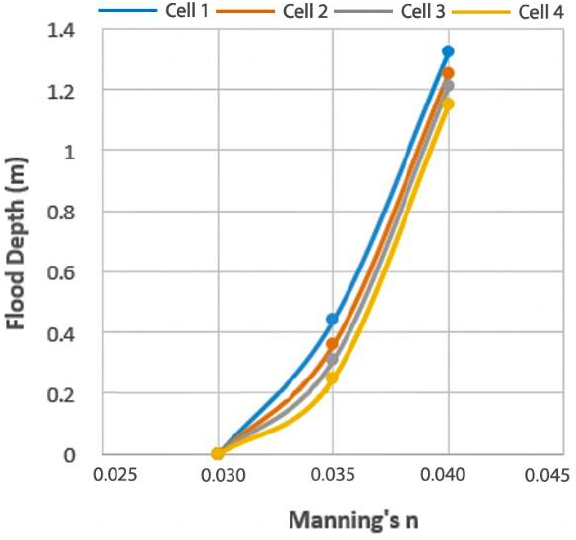
Figure 9. Change in the maximum flood depth (Cells 5–8) value for different Manning’s n in sub-reach K6.